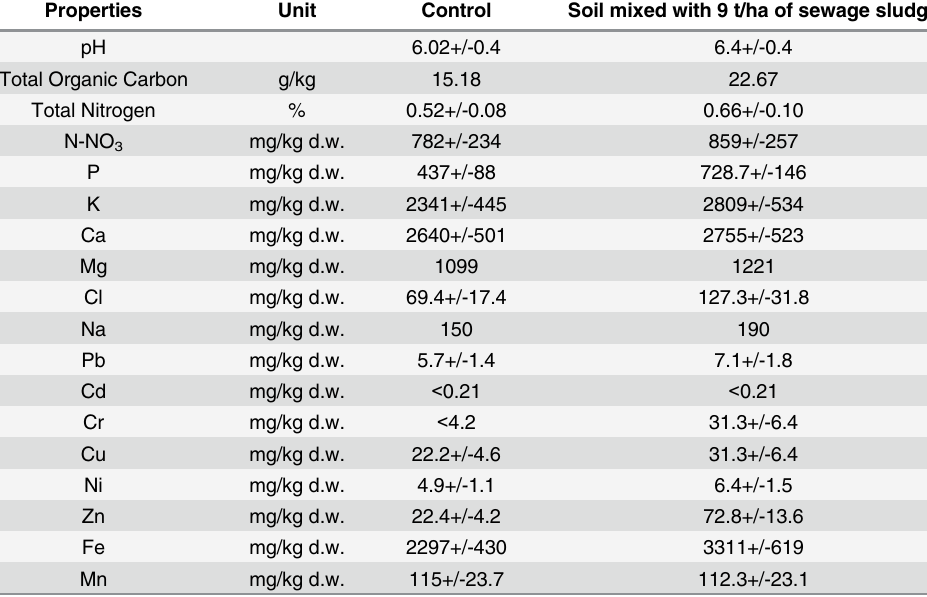
Table 1. Physico-chemical properties of the untreated and sewage sludge amended soil at the dose of 9 t (cid:1) ha -1 .